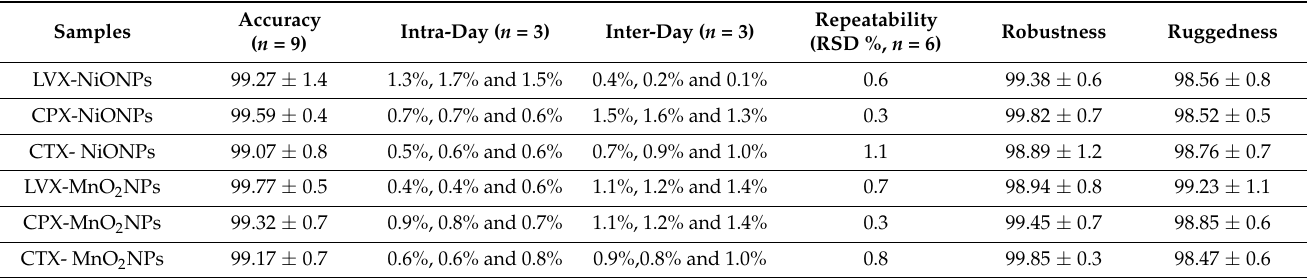
Table 3. Validation data obtained from the determination of LVX, CPX, and CTX in bulk powder using the proposed spectrophotometric method in the presence of NiONPs and MnO 2 NPs, respectively.